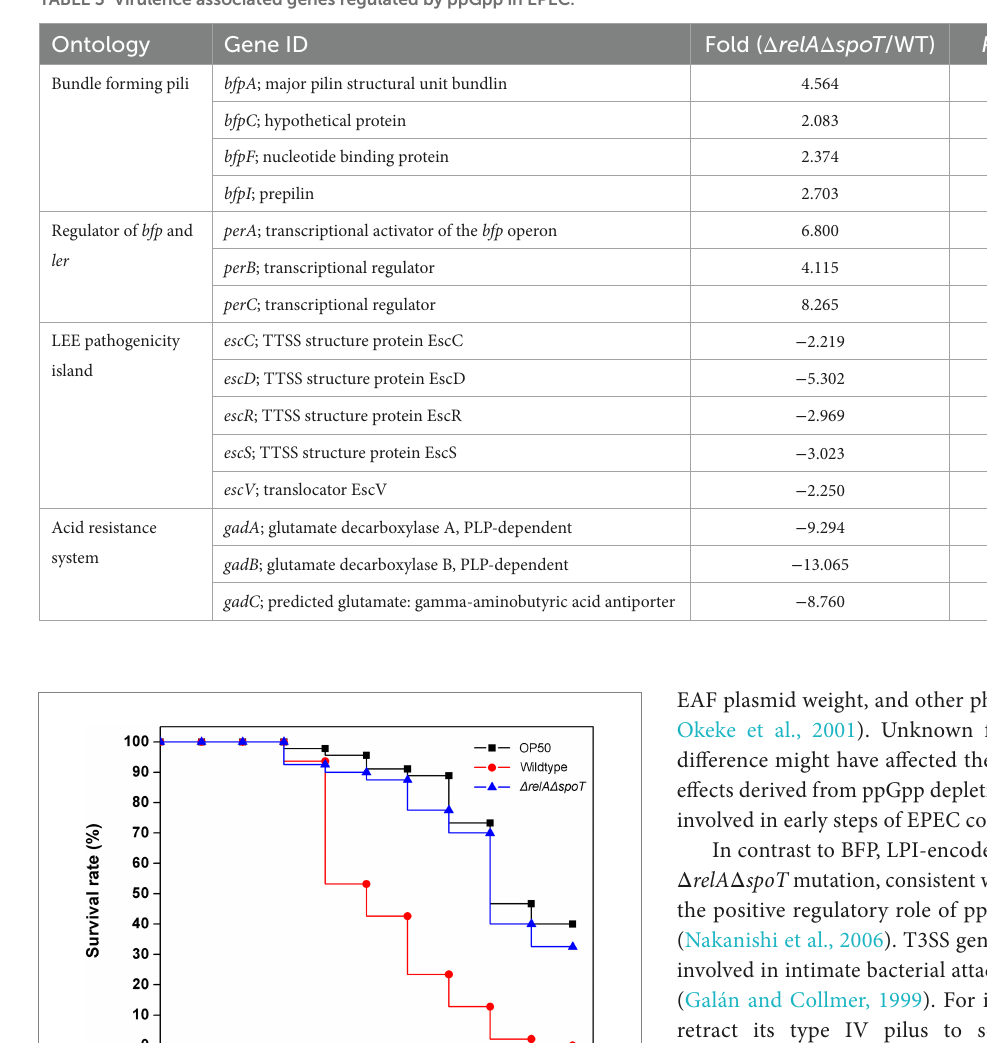
TABLE 3 Virulence associated genes regulated by ppGpp in EPEC.